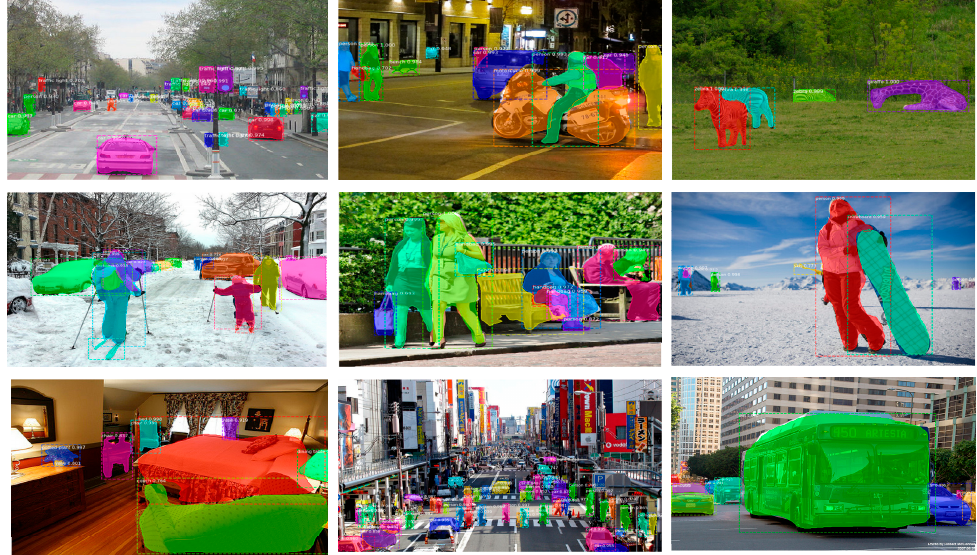
Figure 6. Visualization of YOLACT instance segmentation results based on an adaptive weight loss layer.